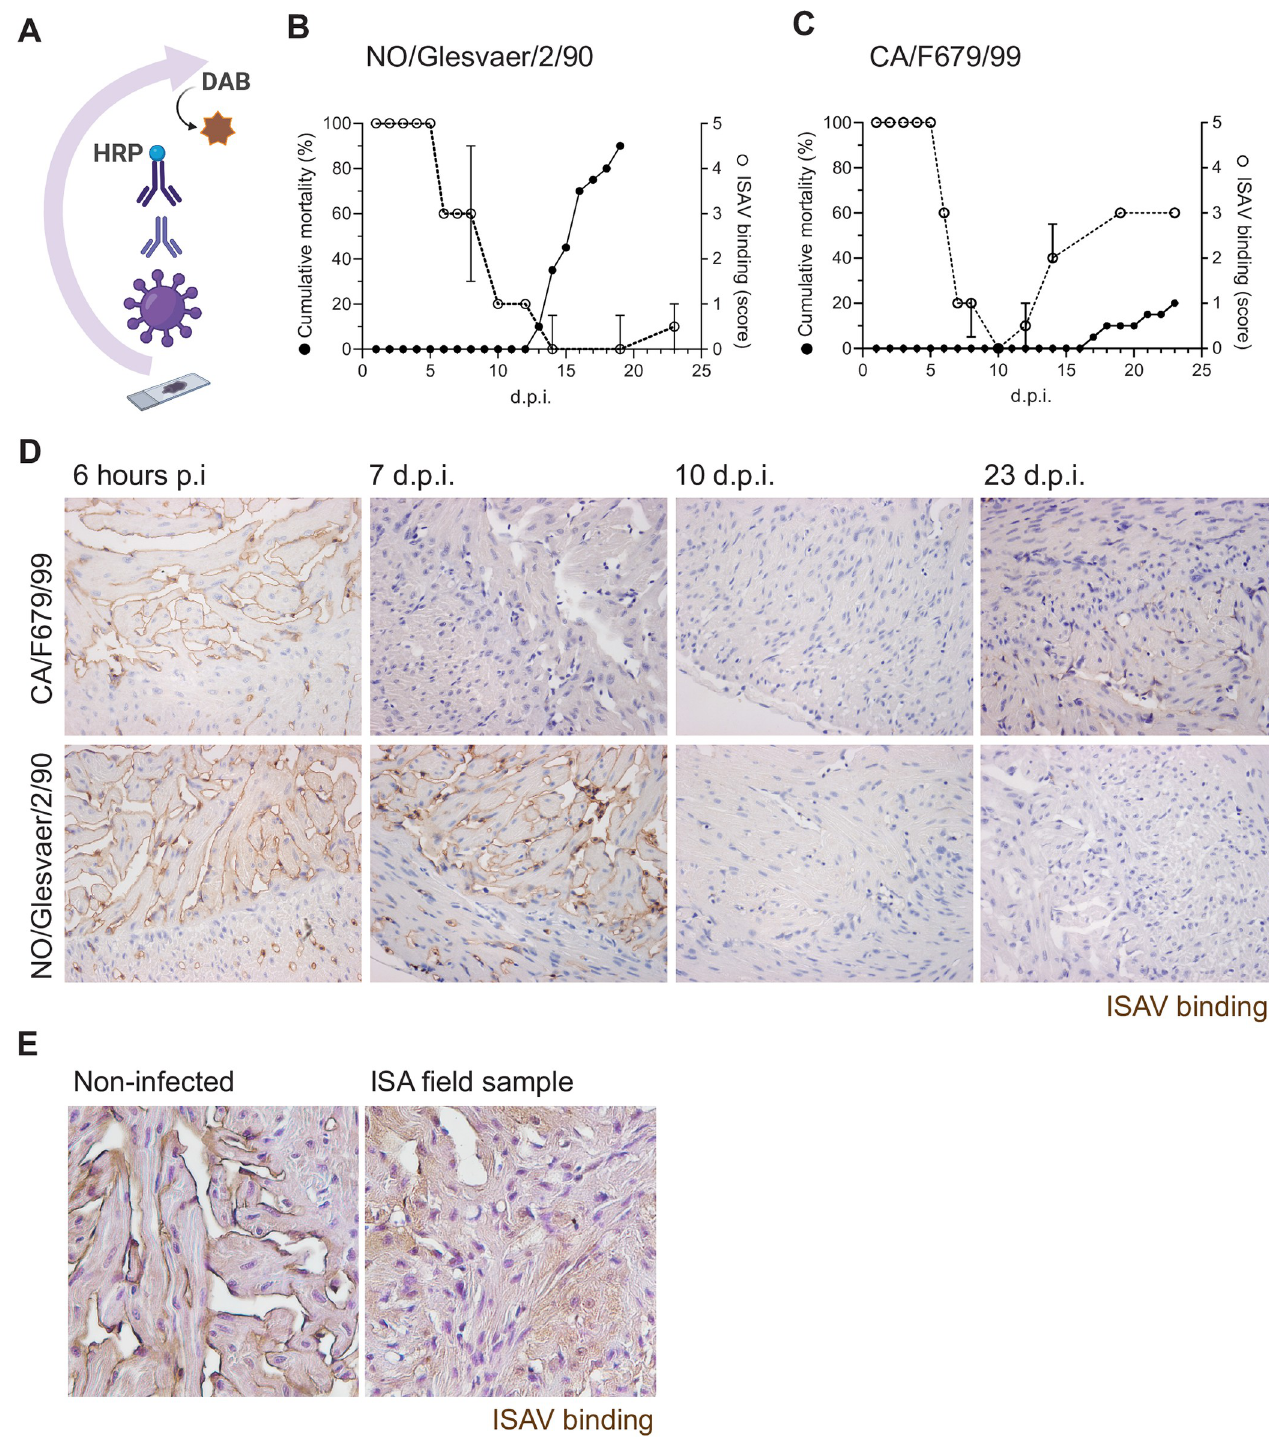
Fig 1. Vascular endothelial cells in ISAV-infected fish become refractory to further ISAV attachment. (A) Tissue expression of the ISAV receptor was mapped by virus histochemistry using ISAV antigen as the primary probe. Binding of the probe was detected by an antibody targeting the virus, a secondary HRP-labelled antibody, and DAB. The illustration was created in Biorender.com. (B-C) Cumulative mortality (black dots and lines) and ISAV binding (open circles, stippled line, data points show median scores +/- 95% confidence intervals) after infection with two different ISAV isolates: (B) High-virulent NO/ Glesvaer/2/90 and (C) low-virulent CA/F679/99. Mortality data from this trial have been published before [35], but are included for context. The loss of ISAV binding was calculated by virus histochemistry on tissue sections from fish harvested 1, 2, 3, 4, 5, 6, 7, 8, 10, 12, 14, 19, and 23 d.p.i. (n = 4 fish per group). (D)